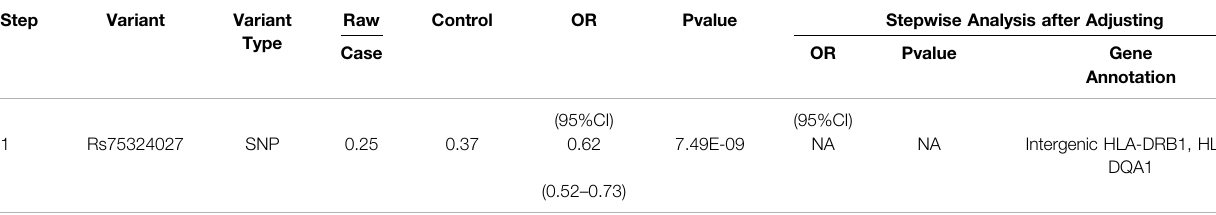
TABLE 1 | Results of stepwise conditional regression analysis of M-S disease.